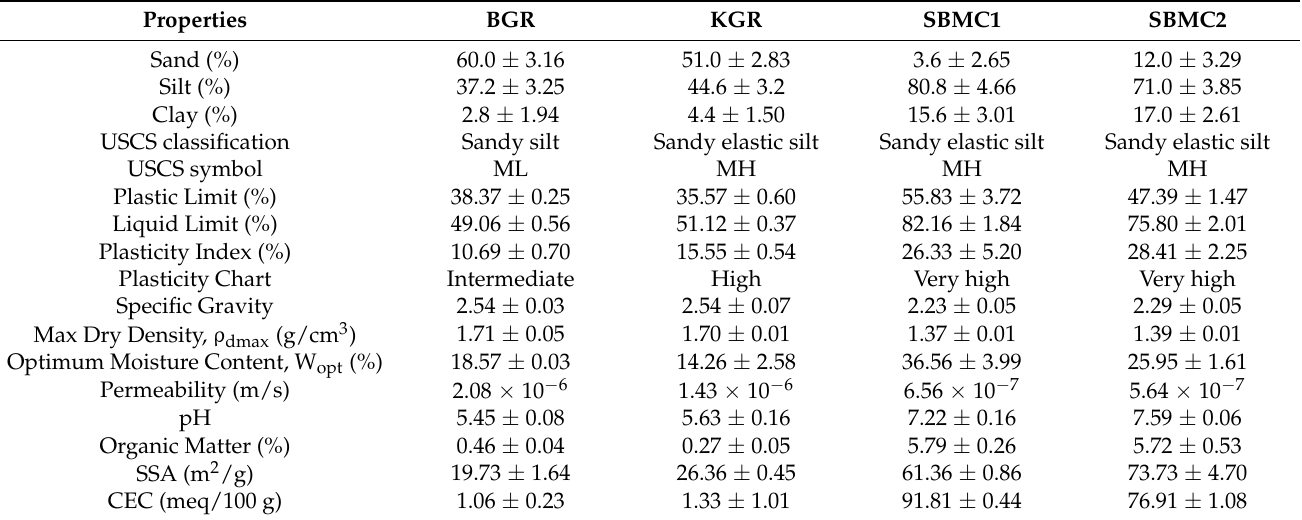
Table 2. Physical and chemical properties of the